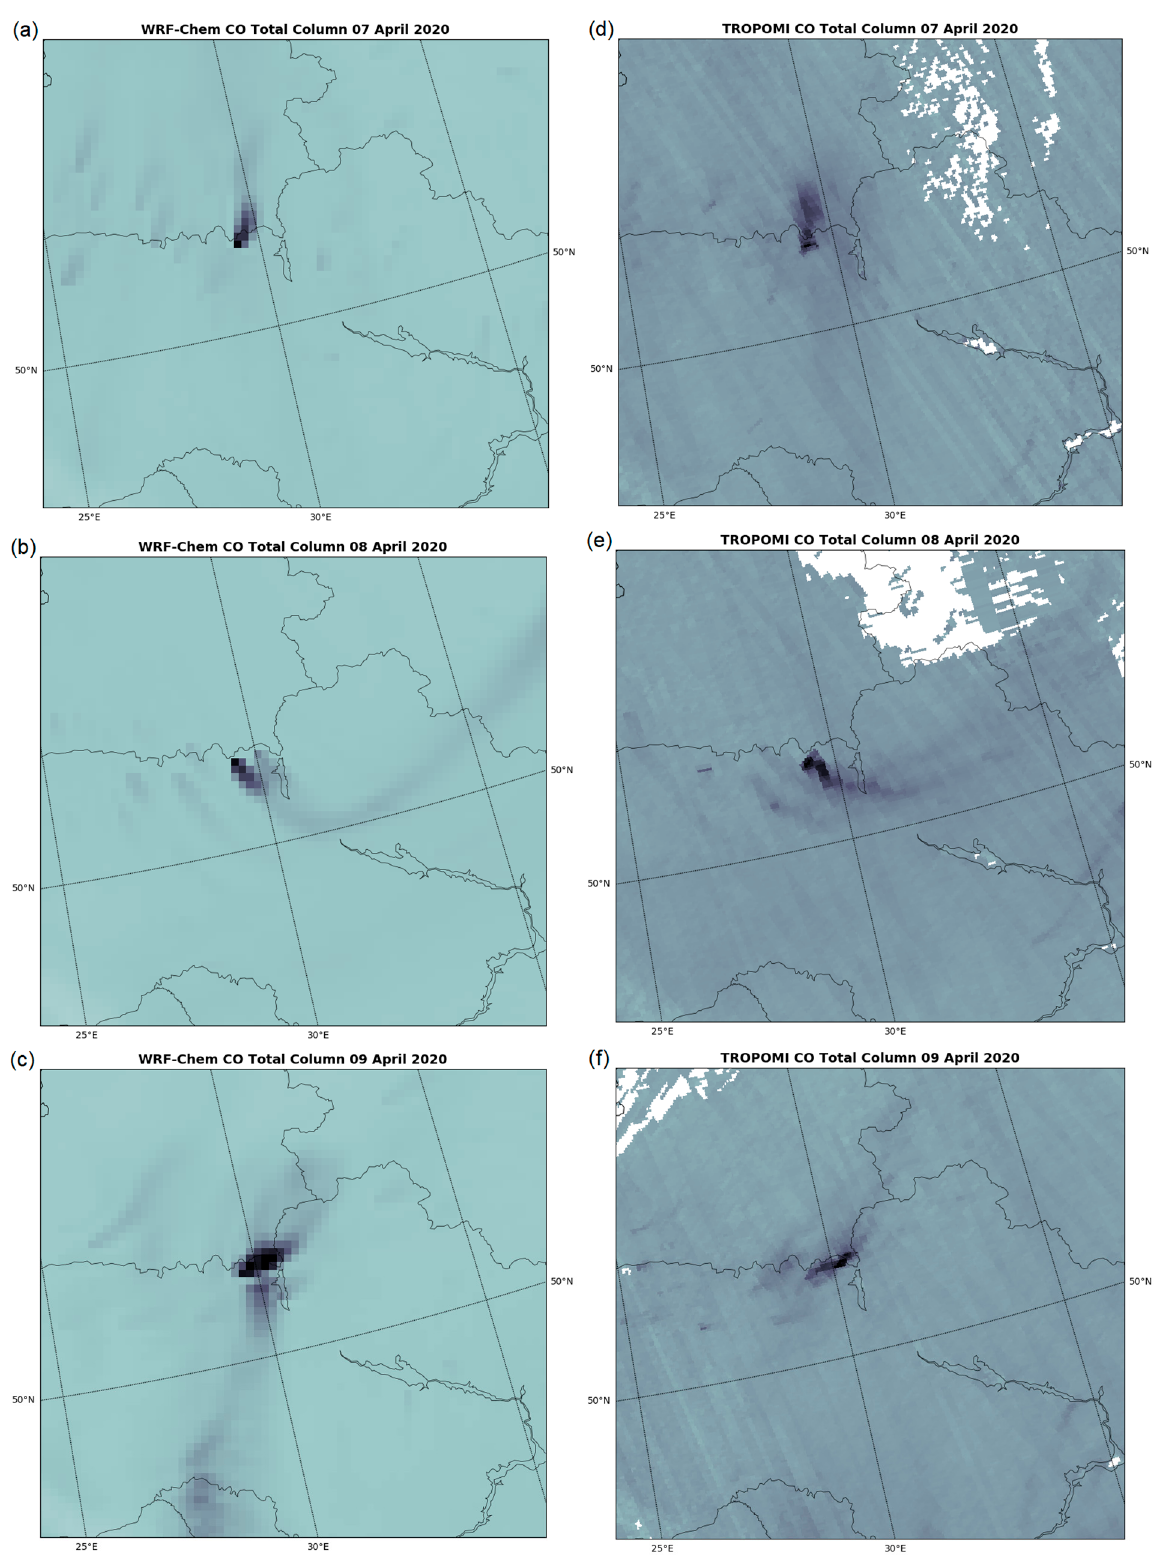
Figure 3. Simulated daily mean CO (mol/m 2 ) with WRF-Chem ( a – c ) and observed CO from TROPOMI ( d – f ) from the 7 to 9 April, 2020.